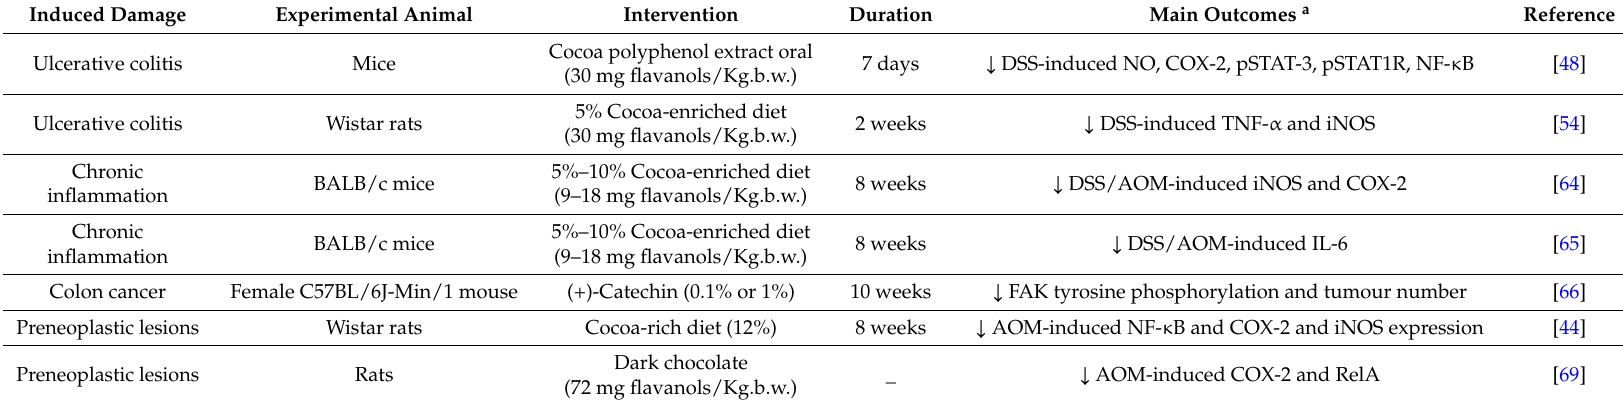
Table 3. Summary of effects of cocoa, cocoa flavanols and cocoa derivatives on inflammation markers in animal models of colon inflammation and